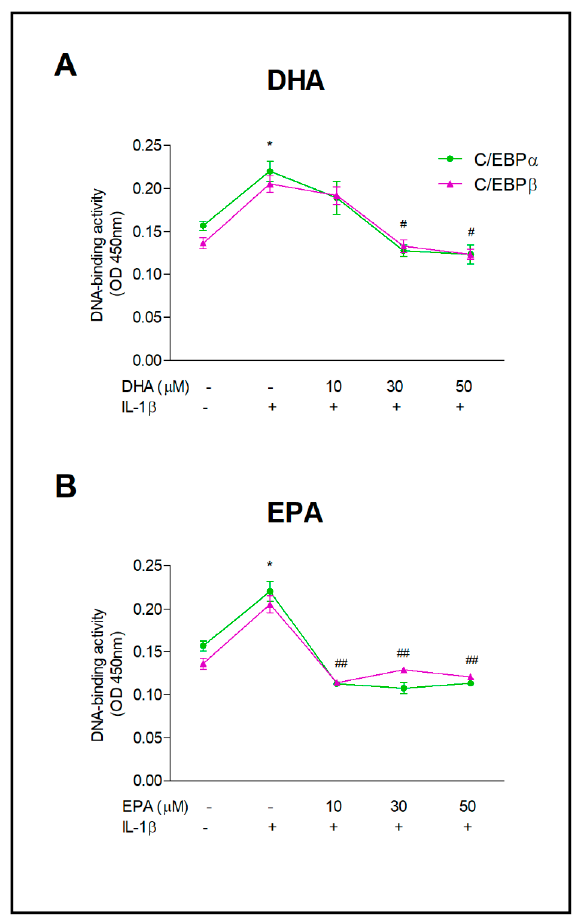
Figure 4. DNA binding activity of C/EBP α and C/EBP β transcription factors in astrocytes incu-